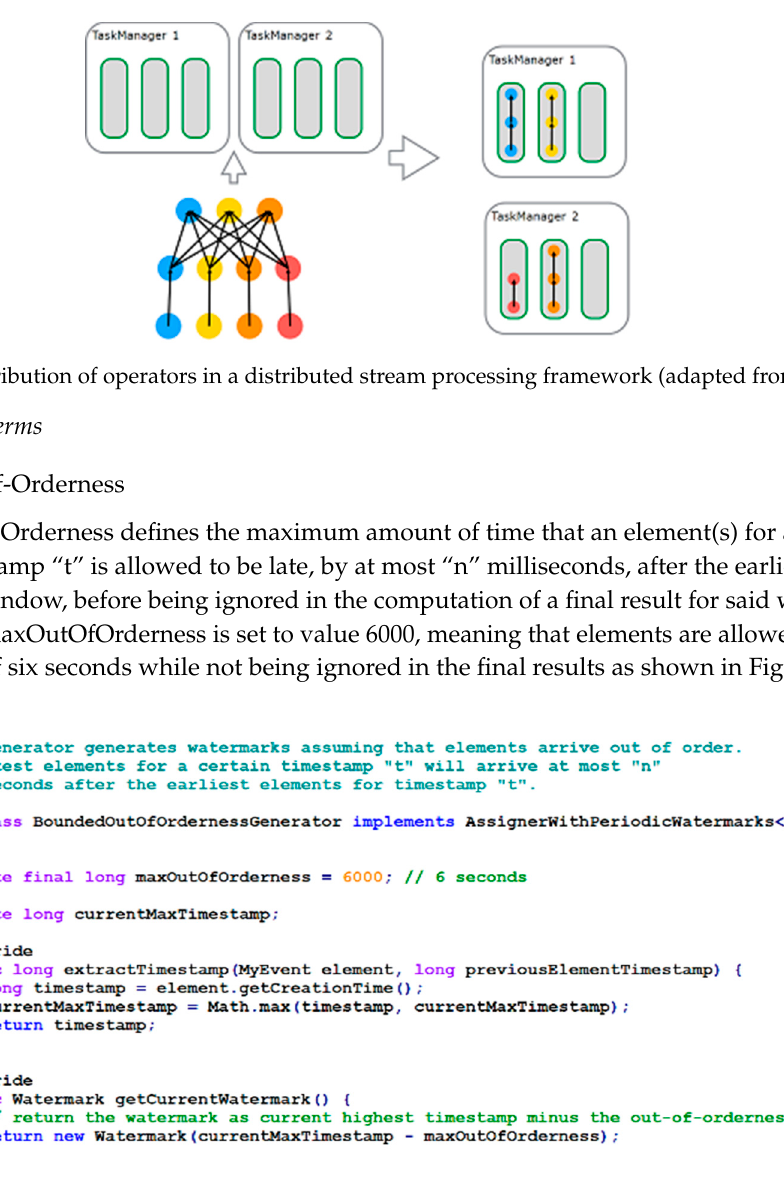
Figure 4. Generating watermark based on the maximum out of orderness of six seconds for the data stream.